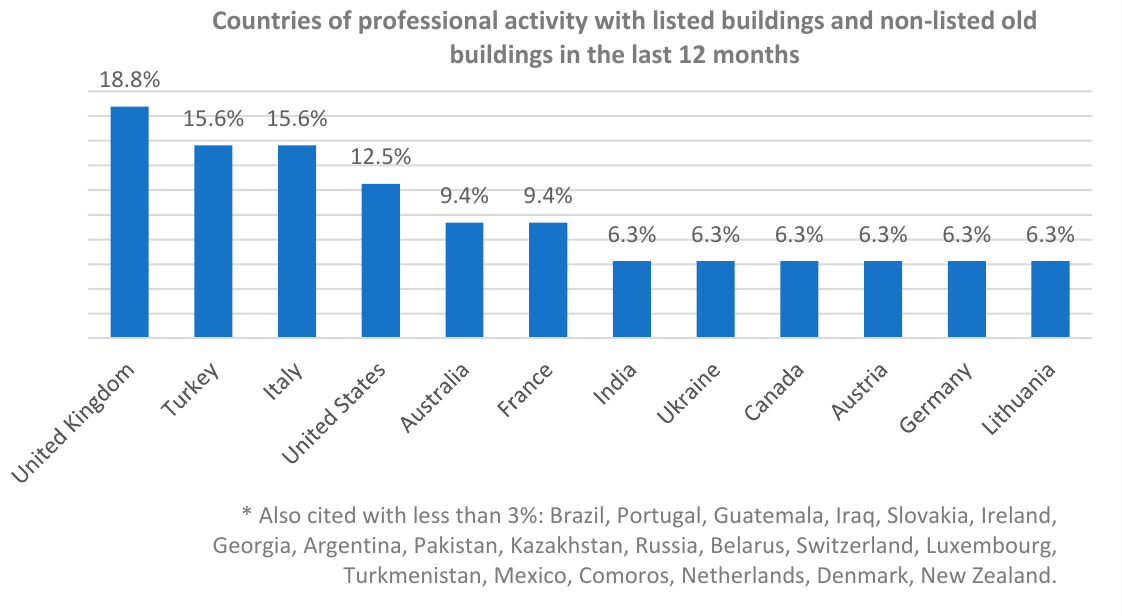
Figure 4. Countries of professional activity with listed buildings and non-listed old buildings in the last 12 months.